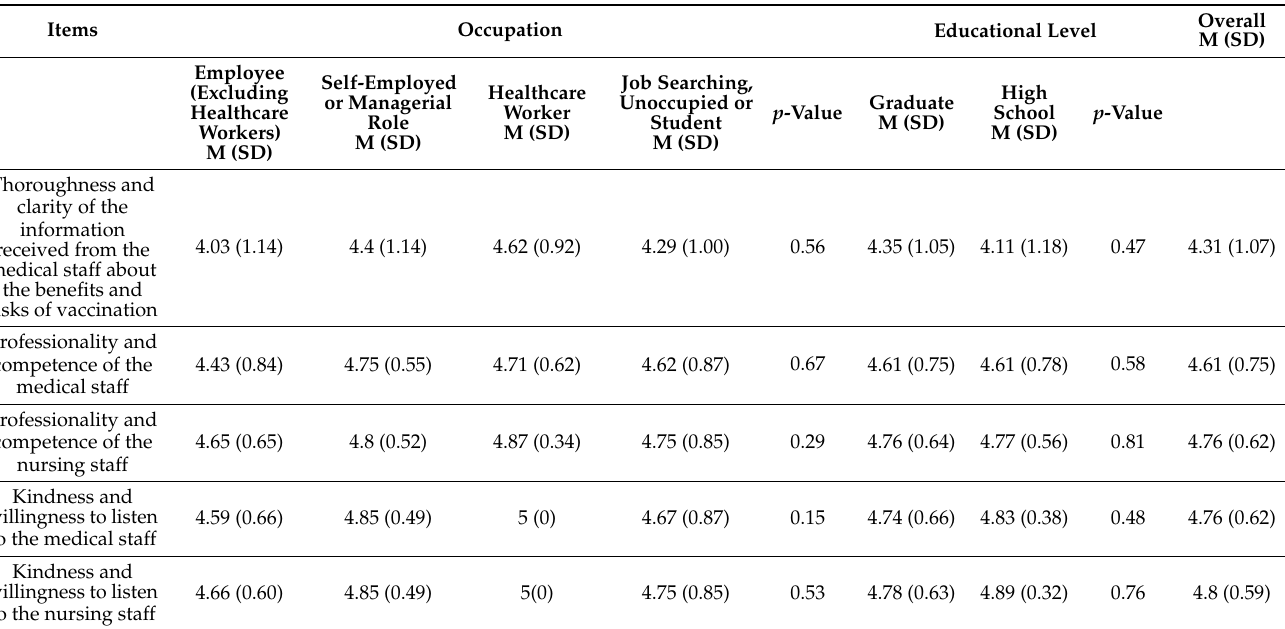
Table 3. Appreciation of the healthcare personnel at the vaccination services, related to occupation and educational level (N =